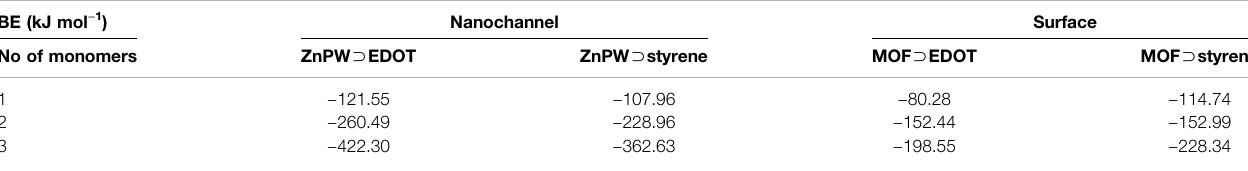
TABLE 1 | UFF-Zenorg binding energies for the most stable MOF I monomer composites. BE (kJ mol − 1